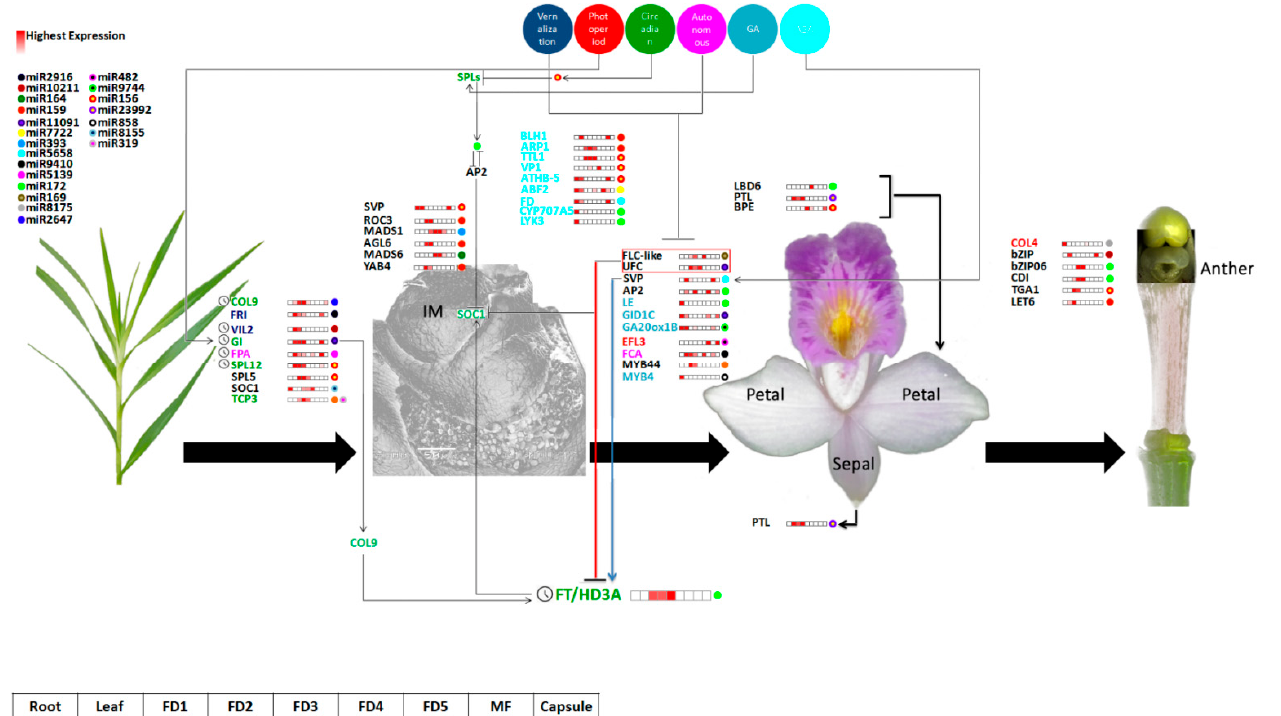
Figure 6. Overview of candidate miRNA targets with their expression intensities and model of miR256 ‒ miR172 mediated control of flowering time. The gene colors correspond to pathway colors at the top.